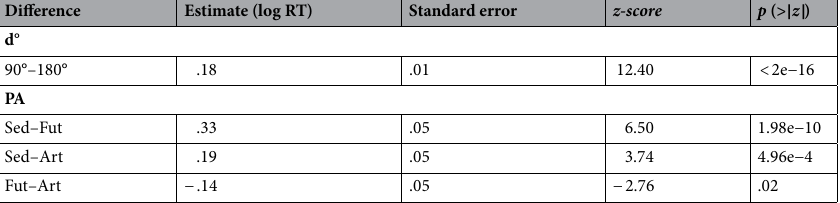
Difference Estimate (log